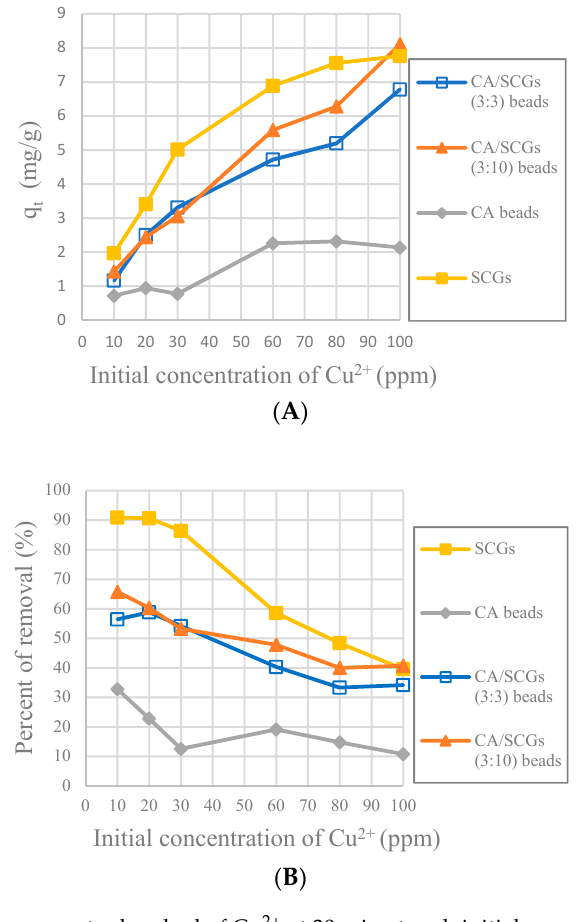
Figure 10. Plots of the amounts absorbed of Cu 2+ at 30 min at each initial concentration of Cu 2+ , ( A ): Experimental amounts of Cu 2+ adsorbed at 30 min (q t ), ( B ): Percentages of removal at 30 min (%).